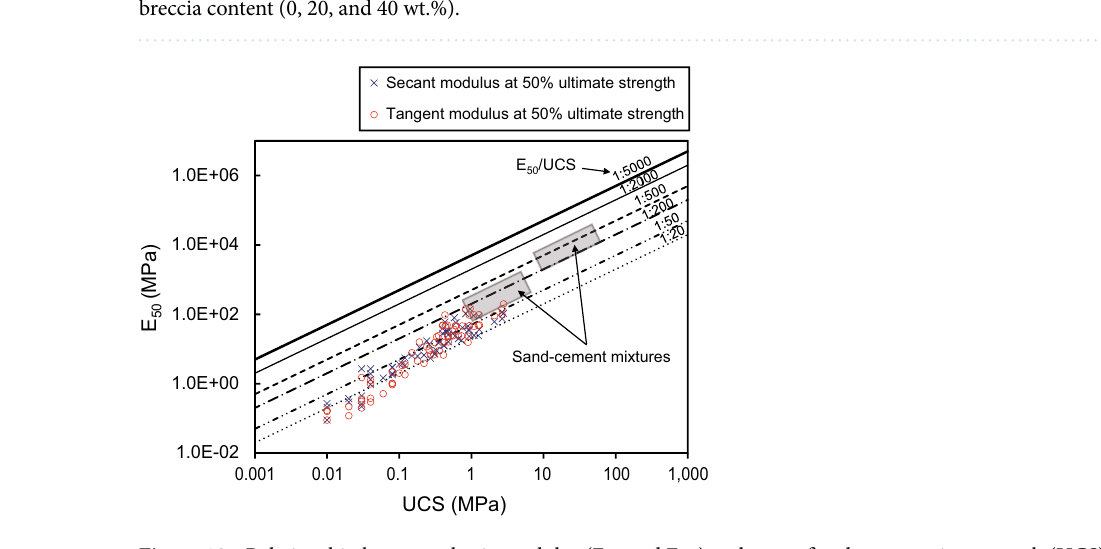
Figure 18. Relationship between elastic modulus (E t50 and E s50 ) and unconfined compressive strength (UCS) for the studied artificial fault cores, with data for soft rocks (ratio lines) and sand–cement mixtures (shaded rectangles) shown for comparison. The artificial fault cores with UCS < 0.1 MPa are located mostly below the 1:50 ratio line, and those with UCS > 0.1 MPa lie mostly between the 1:20 and 1:200 ratio lines. The E 50 /UCS lines and shaded sand–cement data are from Kanji 21 , modified after Kanji and Galván 92 , Galván 44 , and Deere 101